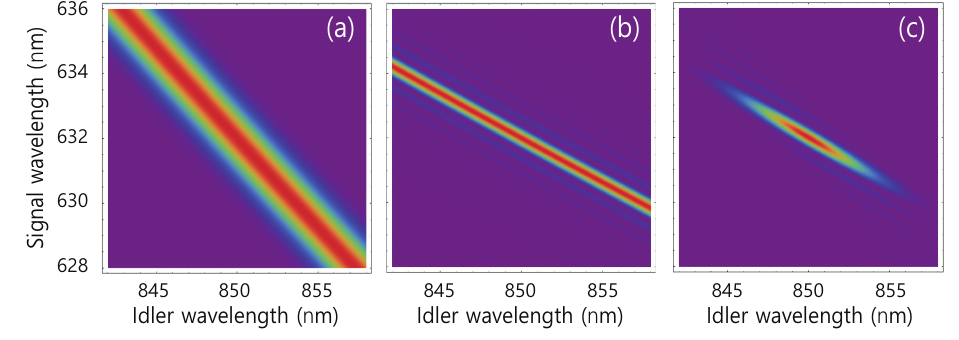
Figure 15. ( a ) Pump envelope function, | α ( ν s , ν i ) | 2 , governed by energy conservation. ( b ) Phase-matching function, | Φ ( ν s , ν i ) | 2 , governed by momentum conservation. ( c ) Joint spectral amplitude, | F ( ν s , ν i ) | 2 , as expressed in Equation (24). λ p = 725 nm, ∆ λ p = 1 nm, and a 12 cm-long MNF with the 615 nm-diameter are used for numerical simulation.